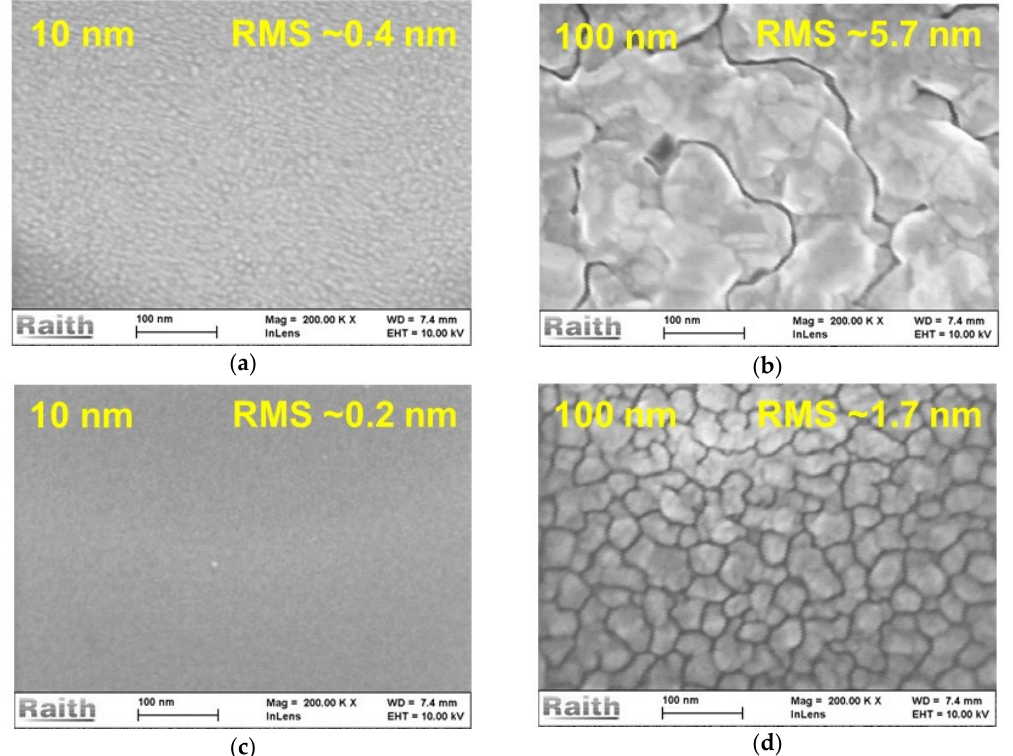
Figure 5. Comparison of the surface state of aluminum films fabricated using: ( a , b ) ‘non-optimal’, and ( c , d ) ‘optimal’ recipe; the thickness, and RMS factor of examined films was also depicted.